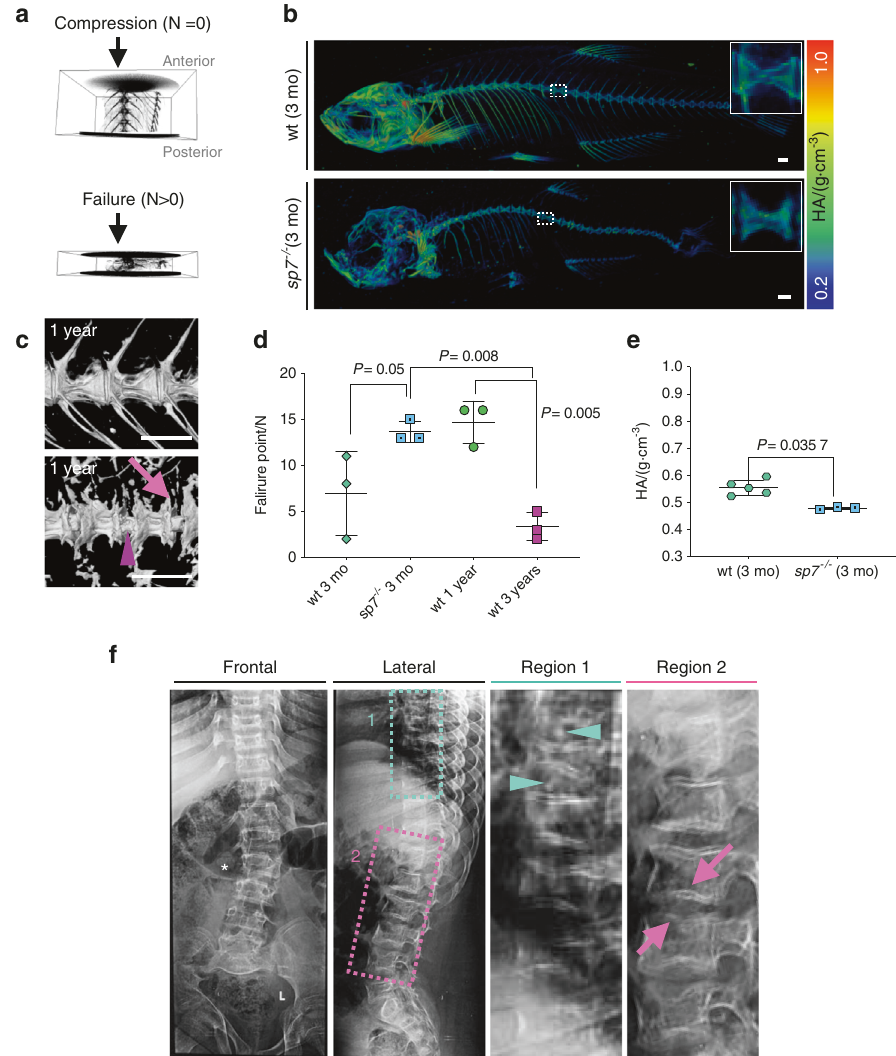
Fig. 2 Altered vertebral column biomechanics in aged and sp7 − / − zebra fi sh show increased bone fragility. a Intact vertebral column motion segments (composed of three vertebrae surrounded by trunk musculature) were placed in a material testing stage (MTS), followed by μ CT imaging at increasing compression forces. An example of vertebral column segments before compression (N = 0) and after failure (N > 0) is shown. Anterior and posterior orientations of the zebra fi sh are annotated. b 3D volumetric rendering from μ CT images of 3-month-old wt and sp7 − / − zebra fi sh color coded for tissue mineral density (TMD). The dashed box shows the magni fi ed region presented on the right of the panel. Scale bars = 500 μ m. c Volumetric rendering from μ CT images of 1-year-old wt and sp7 − / − zebra fi sh. Note IVD calci fi cation (arrowhead) and abnormal shapes of the centra (arrow) in sp7 − / − zebra fi sh. Scale bars = 500 μ m. d Failure points during compressive forces of 3-month-old (3 mo) sp7 − / − zebra fi sh, wt zebra fi sh siblings, 1-year-old wt siblings, and 3-year-old wt siblings ( n = 3 per group). One-way ANOVA and post hoc Holm – Sidak ’ s multiple comparisons test were used; data are the mean and SD. P values are indicated. The graph was generated in Prism 8. Scale bars = 500 μ m. e TMD of 3-month-old (3 mo) wt and s p7 − / − zebra fi sh (wt n = 5 (3 males + 2 females), sp7 − / − zebra fi sh n = 3 (2 males + 1 female)). Standard fi sh lengths: wt = 2.43 cm (0.2 SD); sp7 − / − = 2.17 (0.4 SD). Nonparametric, two-tailed, Mann – Whitney test; data are the mean and SD. P values are indicated. f Radiograph of a 16-year-old male with a frameshift mutation in SP7 (c.1052delA). Frontal and lateral images are displayed. Regions 1 and 2 are magni fi ed and displayed on the right. Lumbar spinal curvature (asterisk), biconcave vertebrae (pink arrows), the spread of IVD, and signs of IVD calci fi cation (cyan arrowhead) are 0.034) (Fig. 2b, e and Supplementary Fig. 5E). Interestingly, endplate sclerosis, calci fi cation and broadening of the IVD (Fig. a meta-analysis evaluating gene variants associated with BMD 2b, c and Supplementary Fig. 5D) suggest premature bone across the lifespan 47 . Mutations in SP7 cause recessive osteogen- degenerative changes. The compressive loading experiment for esis imperfecta (OI type XII), characterized by generalized the section of sp7 − / − spine (3 mo) and comparative sibling osteopenia, recurrent fractures, bone deformities and bent bones 48 – 50 . Zebra fi sh sp7 − / − show frequent fractures in the ribs, samples showed that sp7 − / − areas bent more and suddenly failed skull abnormalities (Wormian bones) and tooth phenotype, similar at 14.67 N ( P = 0.05) (Fig. 2d and Supplementary Fig. 5F, G). Bent to those found in human patients 31,51 . By performing μ CT image long bones have been described in a human patient homozygous for a recessive mutation in SP7 (c.1052delA, p.(Glu351Glyfs*19)) 48 , analysis of young (3 months, mo) sp7 − / − zebra fi sh, we observed a dramatic reduction in TMD in comparison to wt siblings ( p = while vertebral column curvature has also been reported 49,50 , IVD